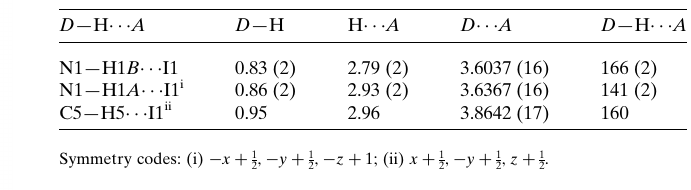
Table 1 Hydrogen-bond geometry (A˚ , (cid:4) ).